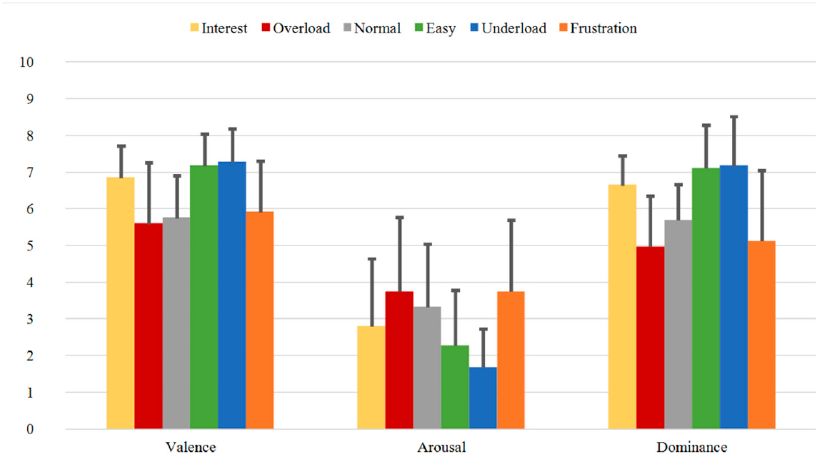
Figure 11. SAM Ratings of Group B3 for all sequences with mean Valence, Arousal, and Dominance.